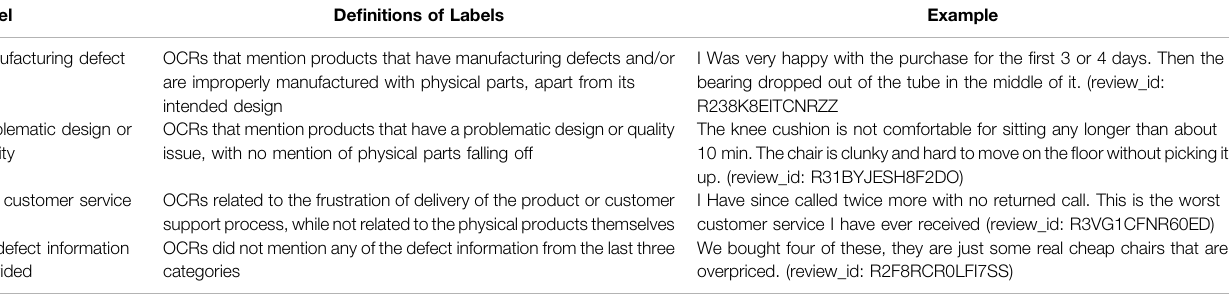
TABLE 1 | De fi nition of AWS SageMaker ground truth labels.